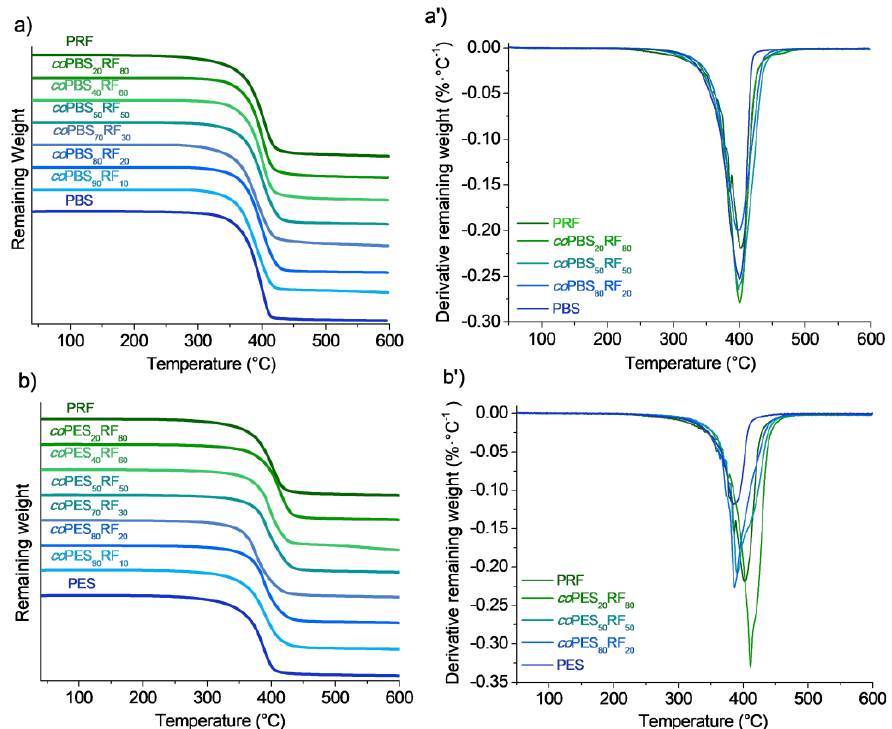
Figure 8. TGA traces of co PBS x RF y and co PES x RF y series ( a , b ) and their derivative curves ( a’ , b’ ).